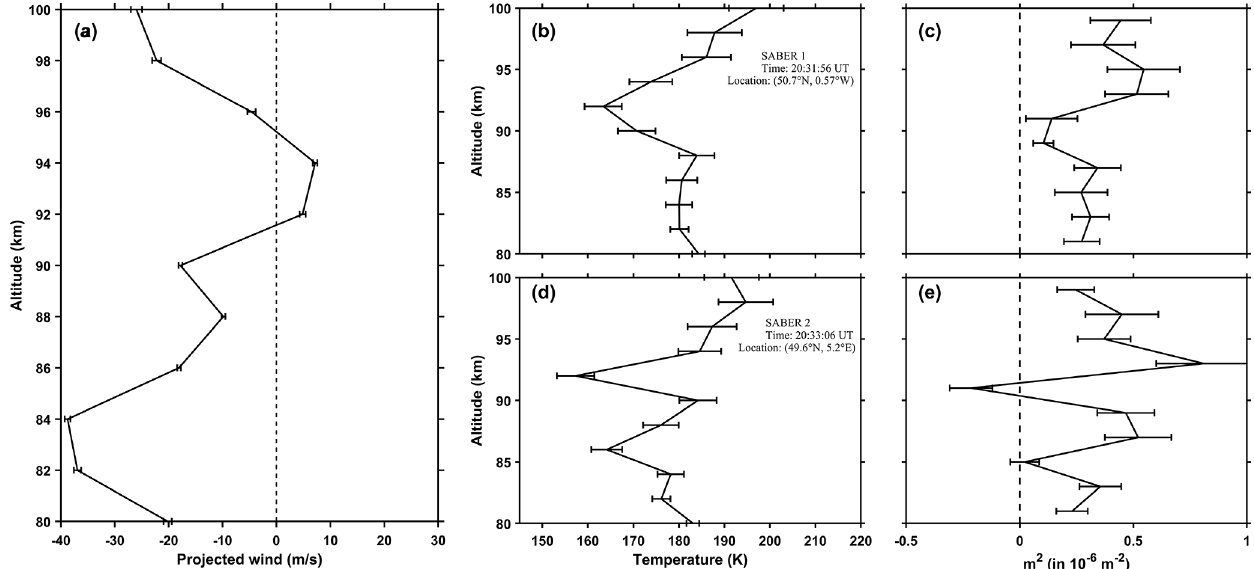
Figure 7. (a) The altitude profile of projected horizontal wind along the wave vector measured during 21:30–22:30UT. (b–c) The altitude profiles of SABER temperature along with measurement uncertainty plotted as horizontal error bar over SABER 1 and 2 locations, respec- tively. (d–e) The altitude profiles of m 2 derived using the Eq. (1) along with the proportional error plotted as horizontal error bar over SABER 1 and 2 locations,